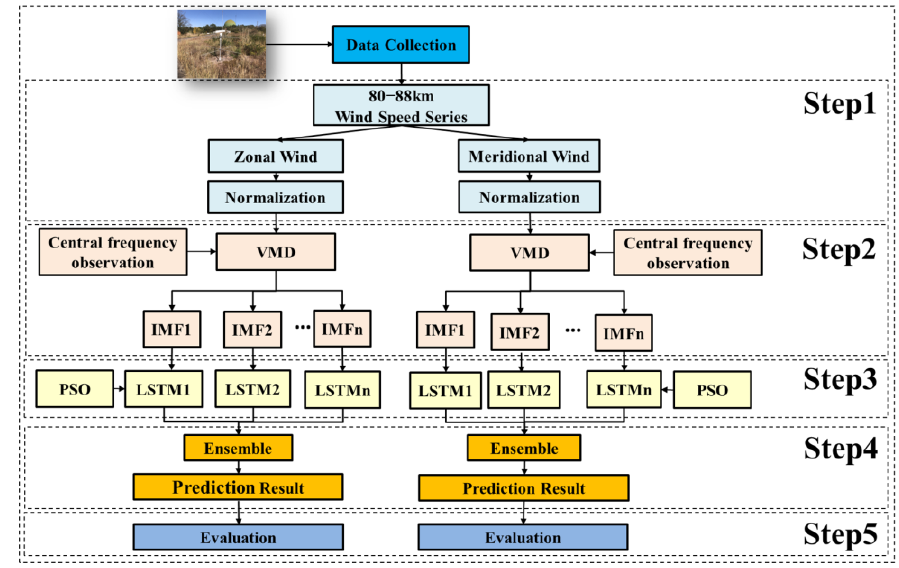
Figure 1. The overall flowchart of the VMD − PSO − LSTM model. From top to bottom are data preprocessing, decomposition algorithm, prediction model, prediction reorganization and model evaluation.